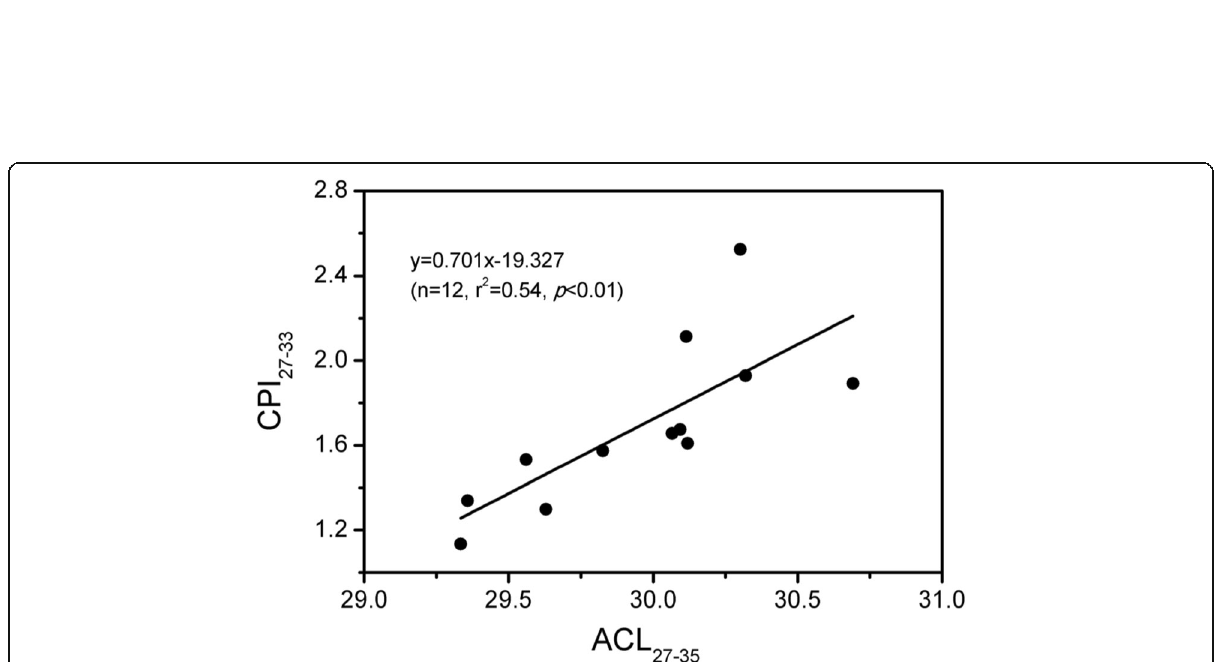
Fig. 4 Relationship between ACL 27 – 35 and CPI 27 – 33 of long chain n -alkanes in the core